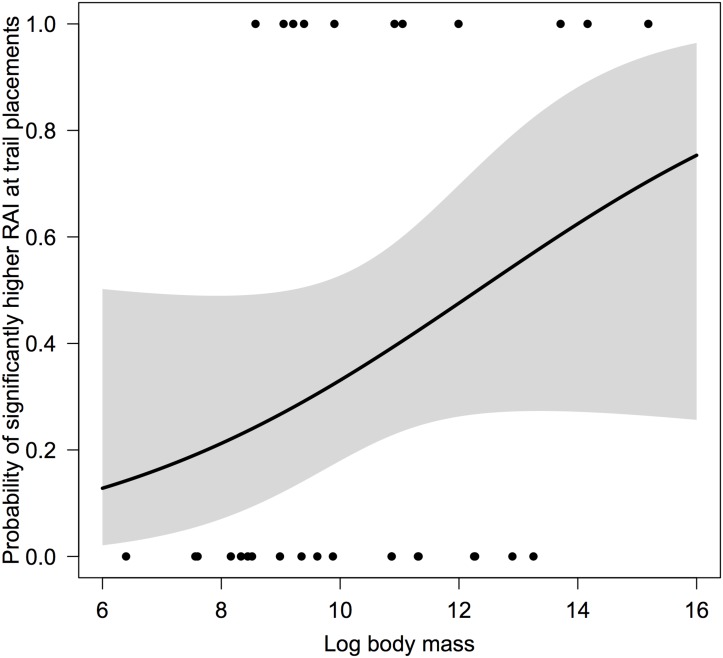
Influence of log body mass on the probability for a species to be caught significantly more often at trail placements during the wet season.The shaded polygon represents the 95% confidence interval surrounding the regression line and black dots represent the species-specific binomial responses used in the generalised linear model.